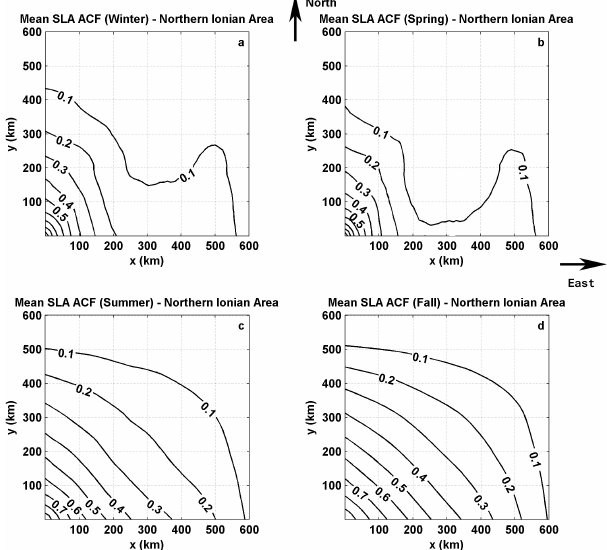
Fig. 2. Contours of the SSH autocorrelation function over the Ionian Sea in the period 1993–2007 averaged over the different seasons. (a) Winter; (b) spring; (c) summer; (d) fall (adapted from Ioannone et al., 2011).